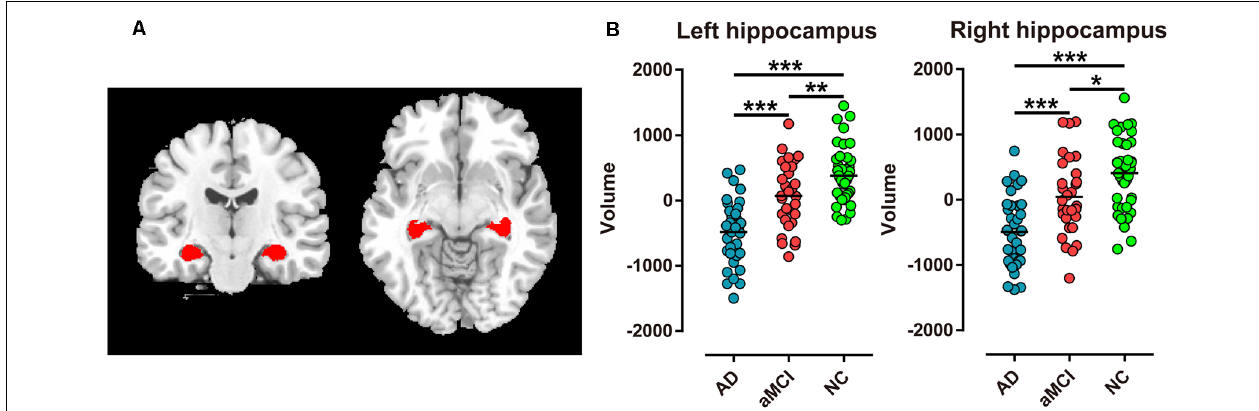
FIGURE 1 | Extraction of bilateral hippocampi and every two groups comparison of hippocampal volume in Alzheimer’s disease (AD), amnestic mild cognitive impairment (aMCI), and normal control (NC) groups. (A) Red regions represent bilateral hippocampi extracted in coronal and transverse sections. (B) Bilateral hippocampal volume was significantly different between the two groups (*** P < 0.001; ** P < 0.01; * P <